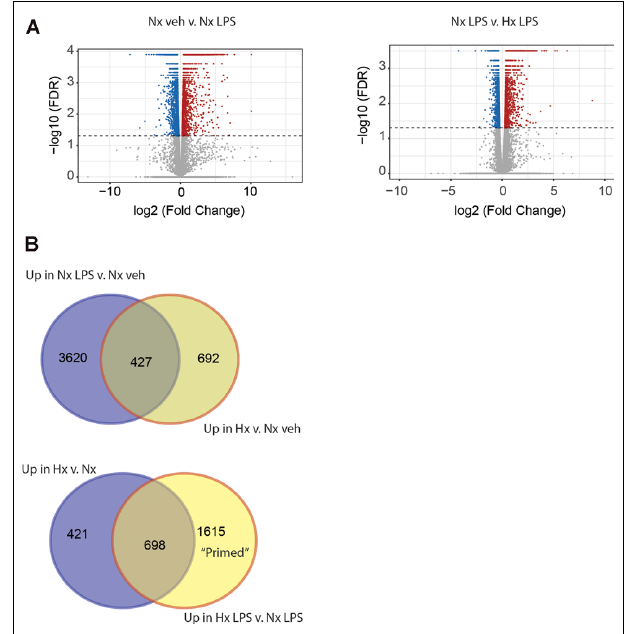
FIGURE 2 | Hypoxia primes lipopolysaccharide (LPS)-induced gene expression. (A) Volcano plots of differential gene expression changes in microglia exposed to Nx LPS vs. Nx veh (left) or Nx LPS vs. Hx LPS (right). Results were analyzed using CummeRbund. Red dots represent significantly (FDR < 0.01) upregulated genes and blue dots represent significantly downregulated genes. (B) Venn diagrams comparing the number of unique and similar genes upregulated in Nx LPS vs. Nx to genes upregulated by Hx (top) vs. Nx and Venn diagrams comparing the number of unique genes upregulated in Hx vs. Nx compared to genes upregulated by Hx LPS vs. Nx LPS. One-thousand six hundred and fifteen “primed” genes are enhanced in Hx LPS vs. Nx LPS that are not upregulated by Hx alone. Results are derived from n = 3 biological